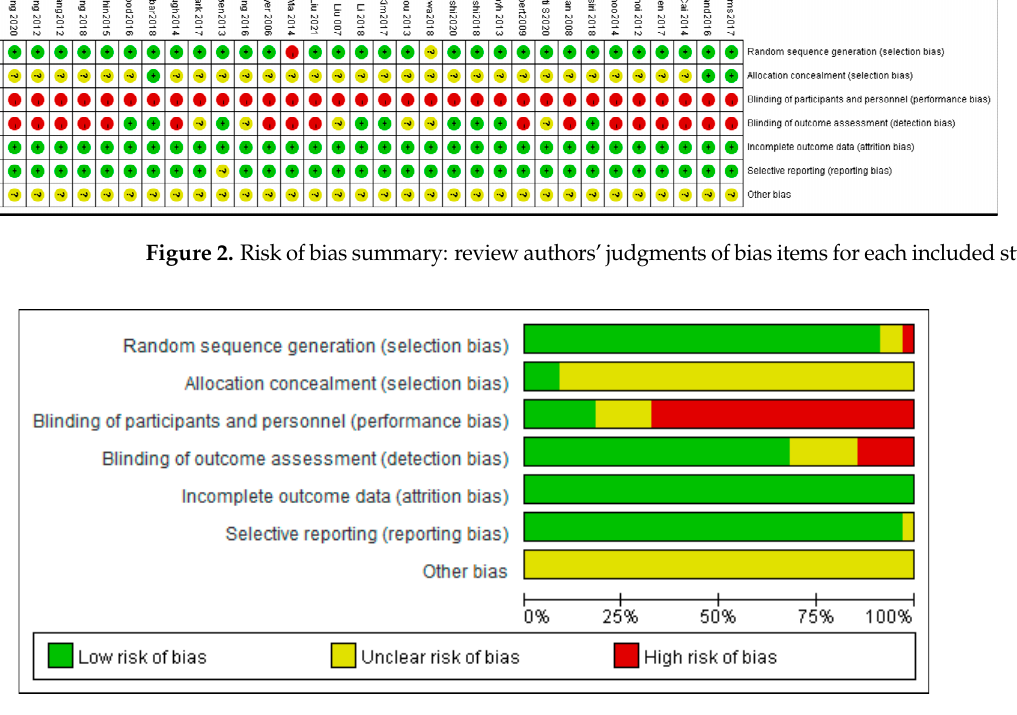
Figure 3. Risk of bias graph: reviewers’ judgments of each bias item, presented as percentages.